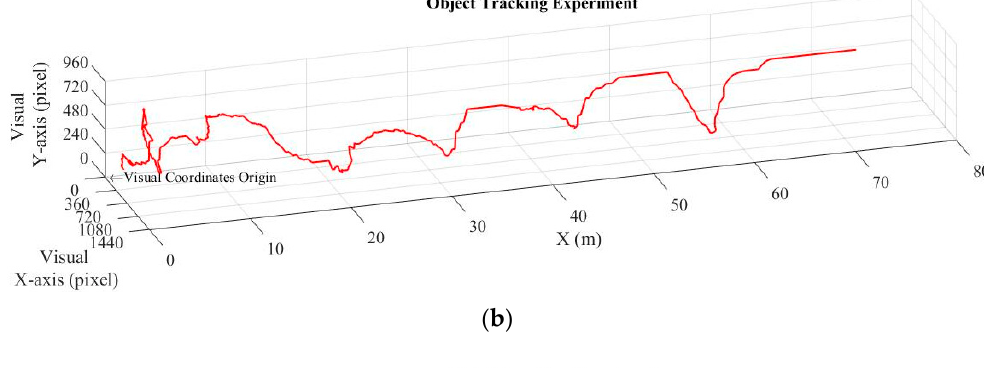
Figure 17. Trajectories of ( a ) AUV in the towing tank, ( b ) visual coordinates, and ( c ) rudder angles.